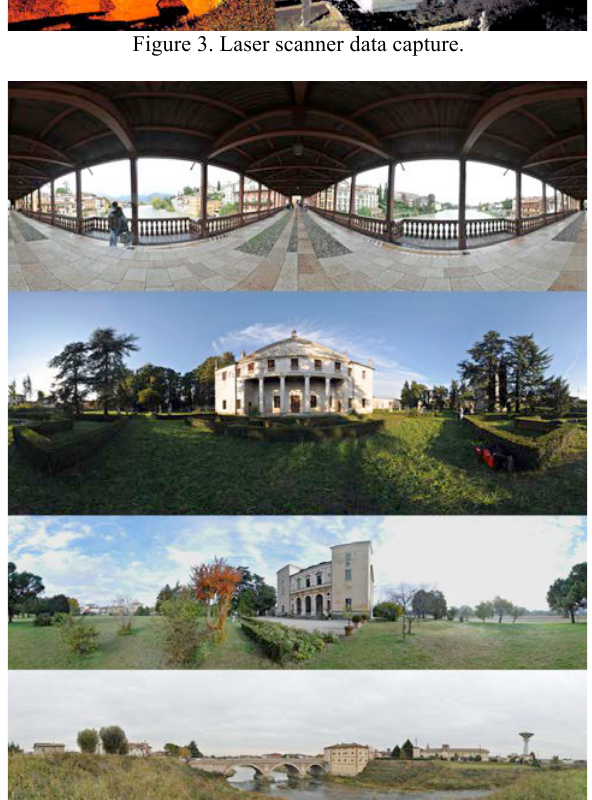
Figure 4. Spherical panoramas data